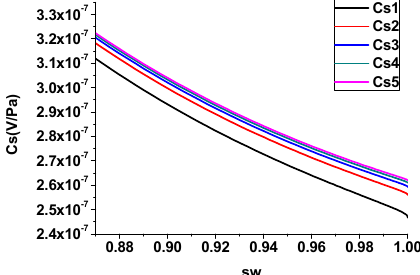
Figure 4. Influence of pore size on streaming potential coupling coefficient (bubbly flow). 0.015 mol/L, 0.03 mol/L, 0.045 mol/L, 0.06 mol/L, and 0.075 mol/L, respectively. It can be